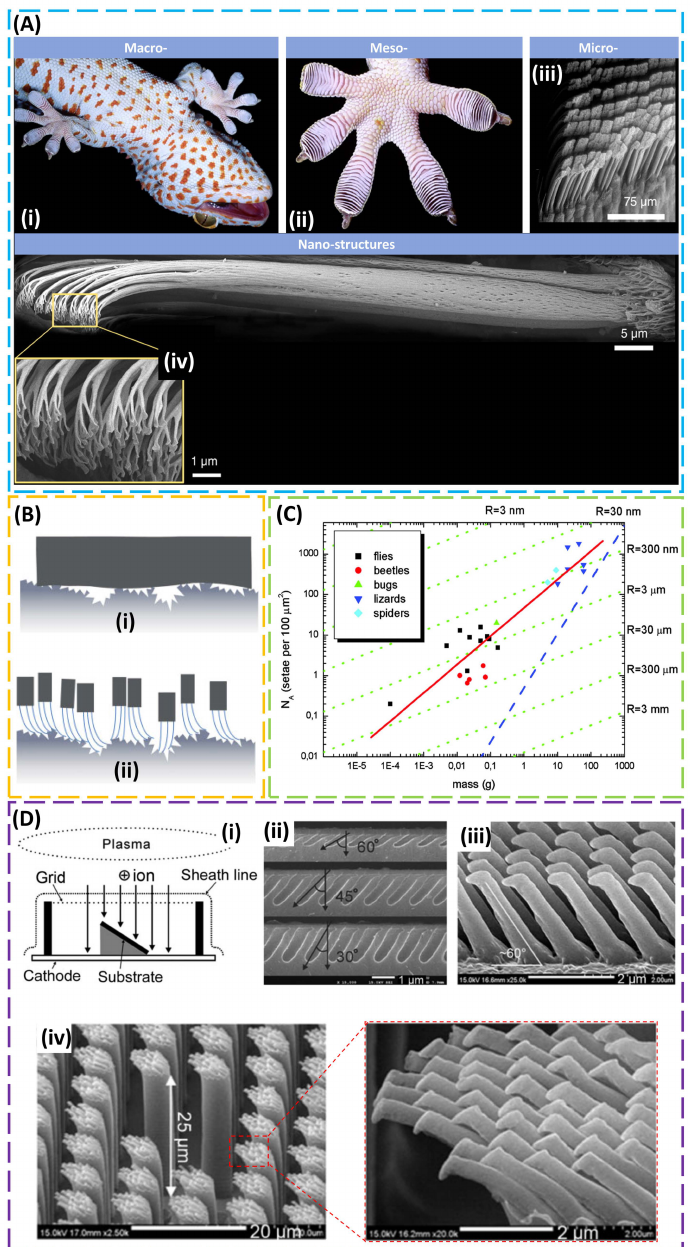
Figure 1. Gecko-inspired dry adhesive. ( A ) ( i ) A close-up view of a gecko climbing a glass wall and ( ii ) mesostructure of gecko toe pad with ( iii ) microscale array of high-aspect-ratio setae structure. ( iv ) Cryo-SEM view of a single seta (ca. 110 µ m in length and 4.2 µ m in diameter) that branches at the tips into 100–1000 more structures known as spatulas. Reproduced with permission from Reference [56]; Copyright 2006, The Company of Biologists. ( B ) Schematic illustrations of adhesives with ( i ) a relatively flat surface and ( ii ) an array of fibrils in contact with a rough surface. Reproduced with permission from Reference [49]; Copyright 2010, John Wiley and Sons. ( C ) Dependence of the terminal element density (N A ) of the attachment pads on the body mass (m) in hairy-pad systems of diverse animal groups. The red line that fits all data corresponds to the self-similarity criterion with a slope of ~0.67. The green lines (slope of ~0.33) correspond to the model with a curvature invariance of contacts with radius R . The blue line shows the approximate limit of maximum contact for such attachment devices. Reproduced with permission from Reference [47]; Copyright 2003, United States National Academy of Sciences. ( D ) ( i ) A schematic showing the mechanism of a plasma sheath with a Faraday cage,